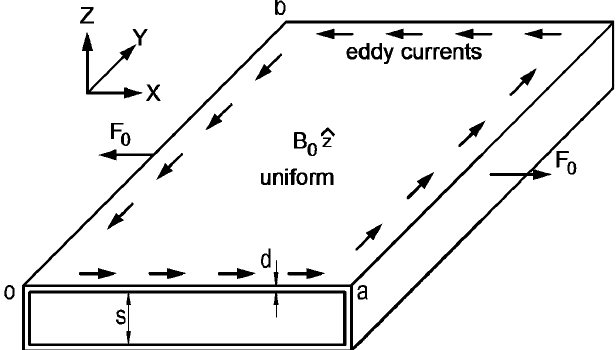
FIG. 3. Coordinate system, geometry of the chamber and the direction of eddy current and the force ( F 0 ) is shown when the chamber is exposed to a spatially uniform but exponentially time decaying magnetic field, B 0 (case I).